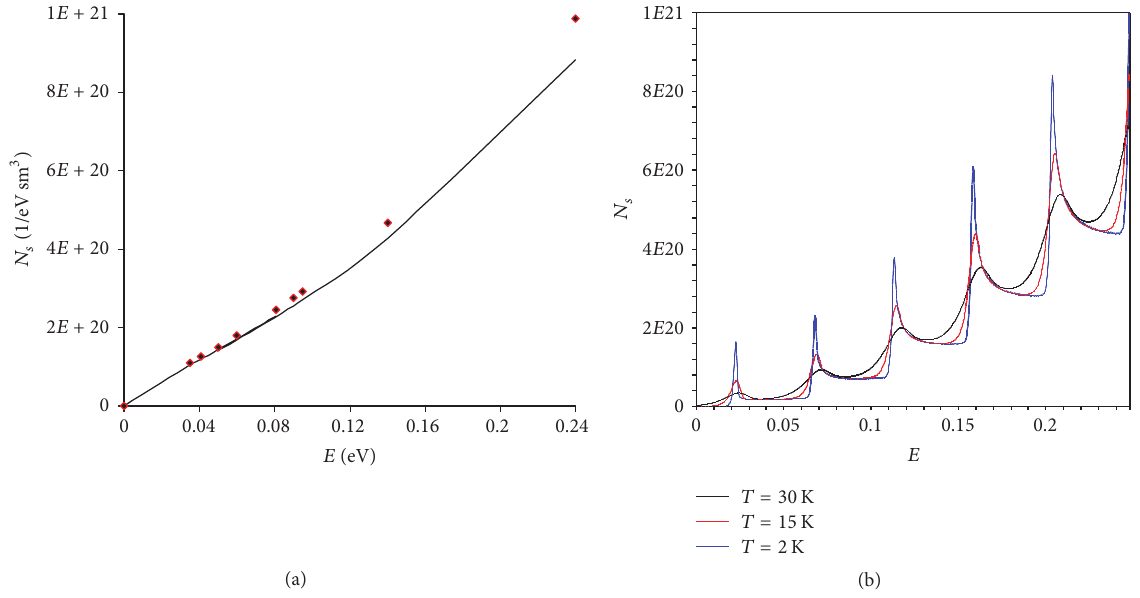
Figure 3: Determination of the change in the density of energy states with decreasing temperature in high magnetic fields using the Kane model. (a) The experimental data (dots) for PbTe at 𝐻 = 30 kOe [3, 4] and the theory of calculation (solid line) for 𝑇 = 77 K. (b) The density of the energy states of a nonparabolic dispersion law for three different values of the temperature in a magnetic